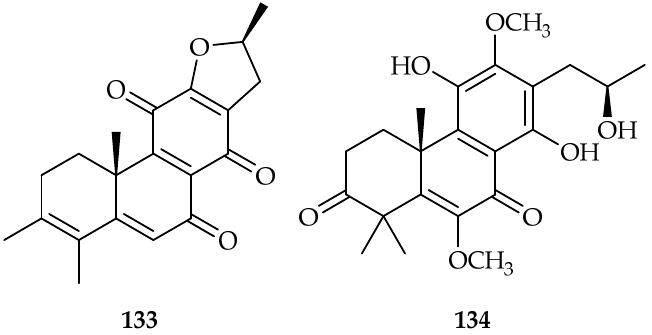
Figure 55. Structures of compounds 133 and 134 [84].